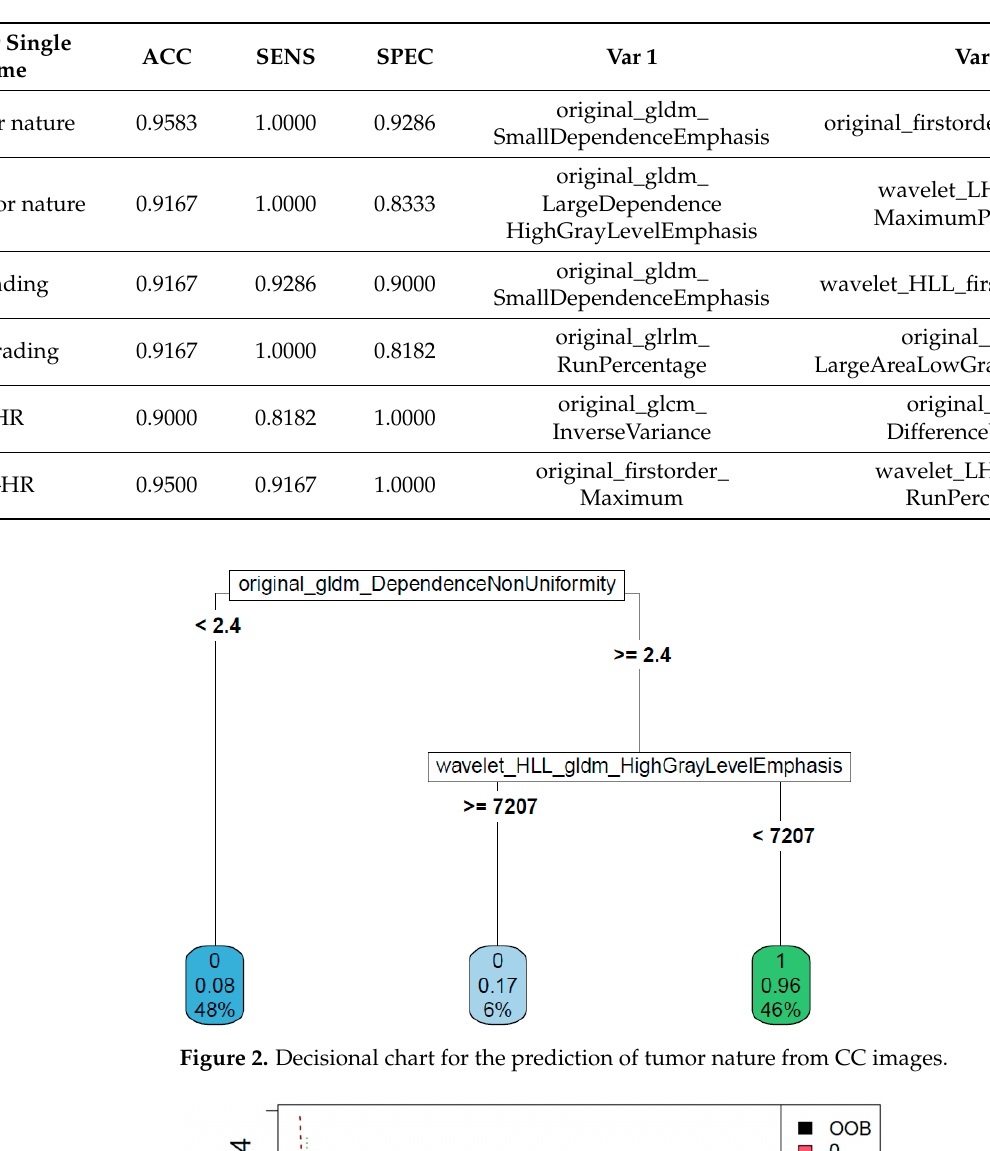
Table 4. Results for CART and RF methods.